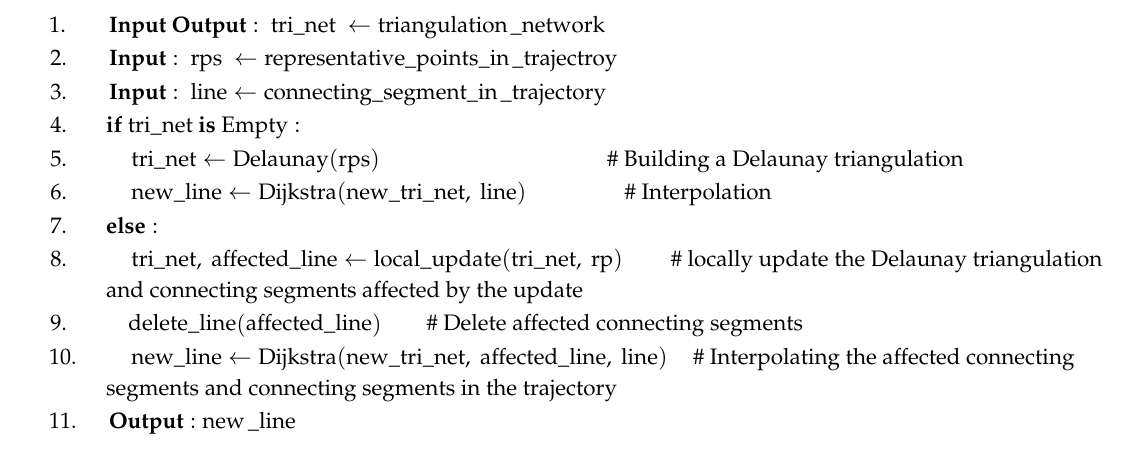
Algorithm 3 Road network generation and update algorithm